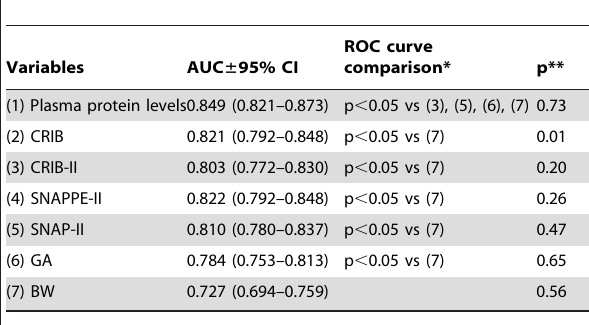
Table 3. Predictive accuracy of plasma protein levels, CRIB, CRIB-II, SNAP-II, SNAPPE-II, birth weight (BW) and gestational age (GA) in identifying severe adverse outcome in the study